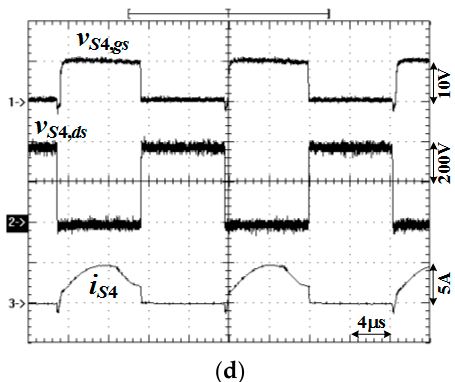
Figure 10. Test waveforms of the active devices ( a ) S 1 (leading-leg switch) under 20% load and 800 V input ( b ) S 1 (leading-leg switch) under rated power and 800 V input ( c ) S 4 (lagging-leg switch) under 20% load and 800 V input ( d ) S 4 (lagging-leg switch) under rated power and 800 V input.